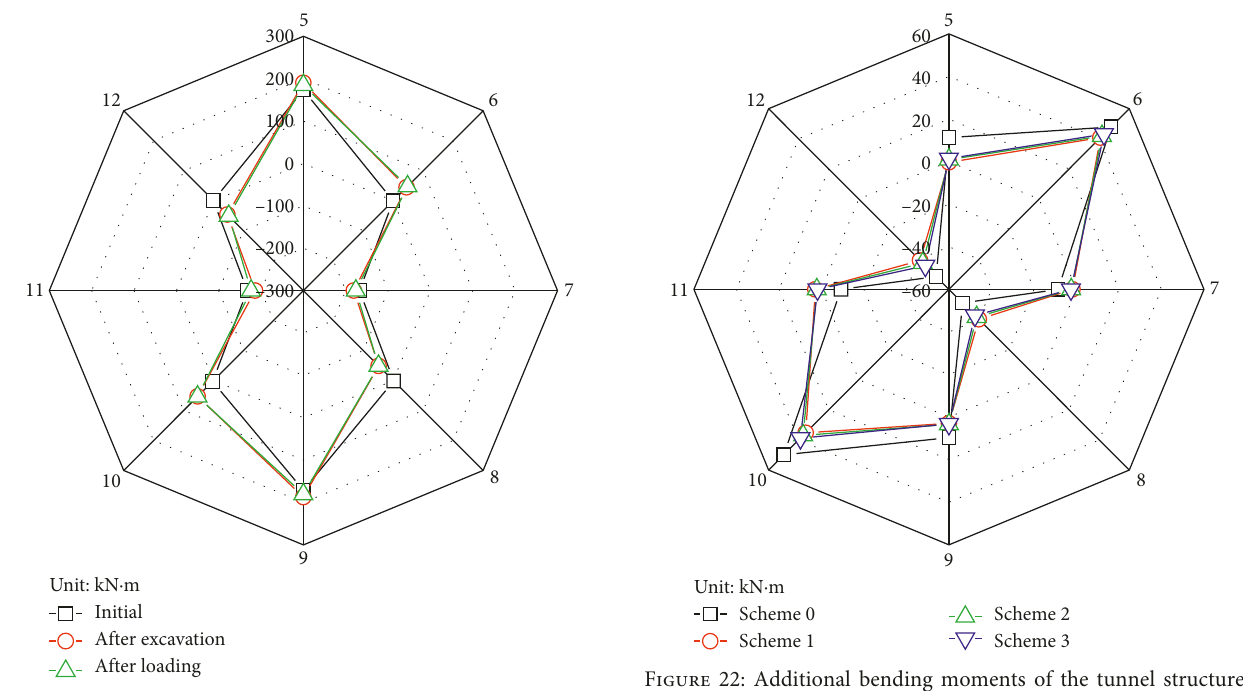
Figure 20: Bending moments of the transverse tunnel structure in scheme 0.